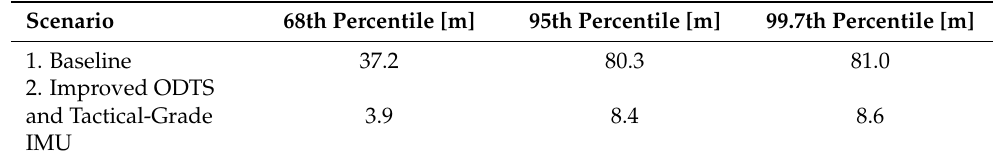
Table 14. Statistics highlighting the gain in performance in case of an improved ODTS accuracy and